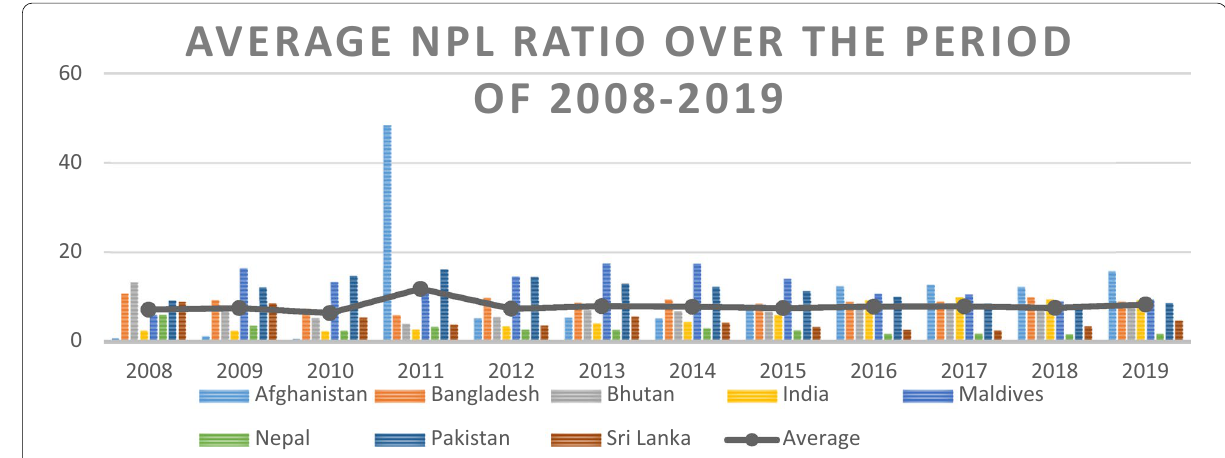
Fig. 2 Trend of average NPL ratio during the period of 2008–2019 in SAARC countries Source : Author’s complication